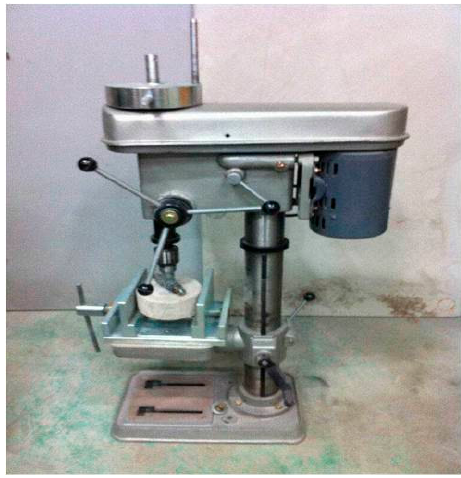
Figure 4. Abrasion test set-up.